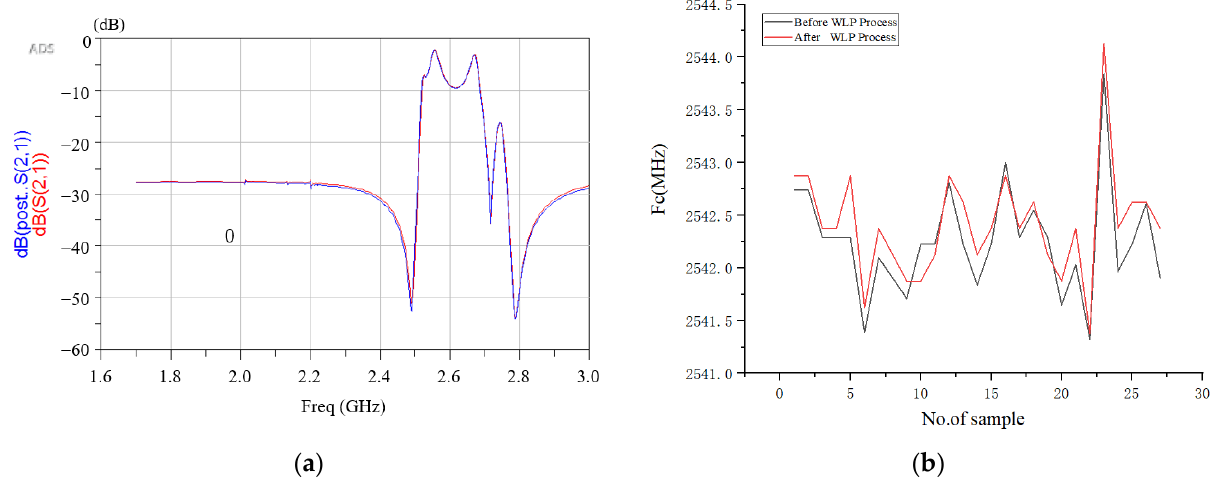
Figure 15. Measurement result of frequency response for RF filter ( a ) The insertion loss in passband; ( b ) The measured center frequency of RF filter.